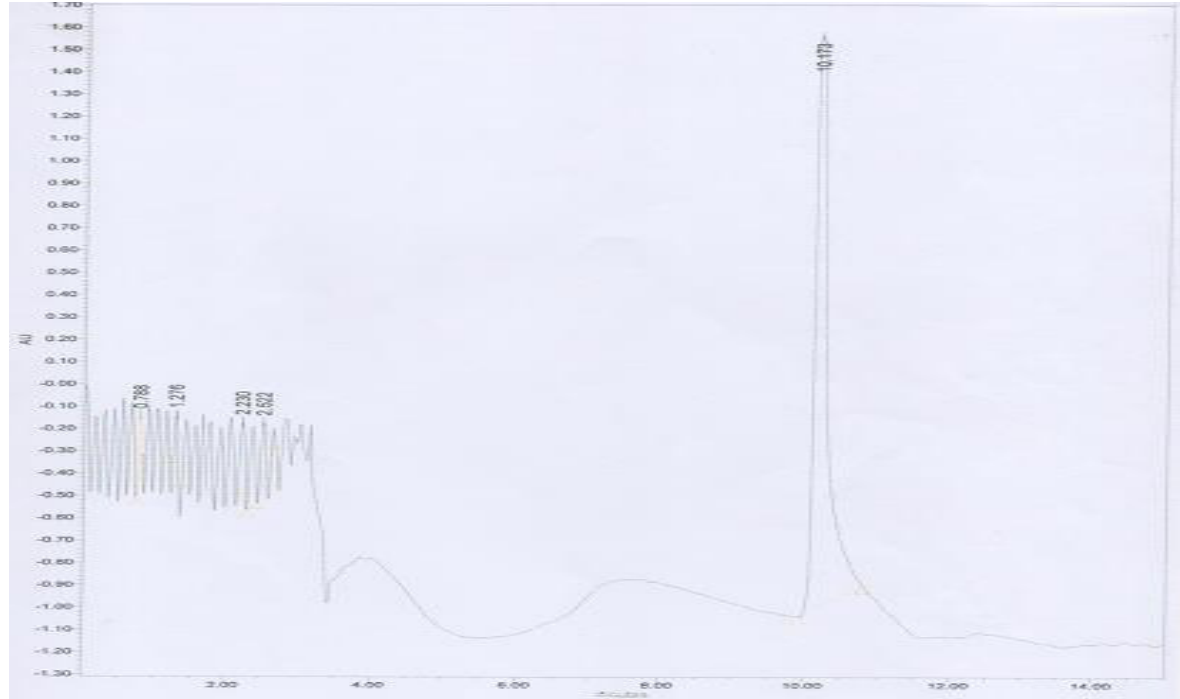
Figure 4: HPLC analysis of hederacoside C reference standard .